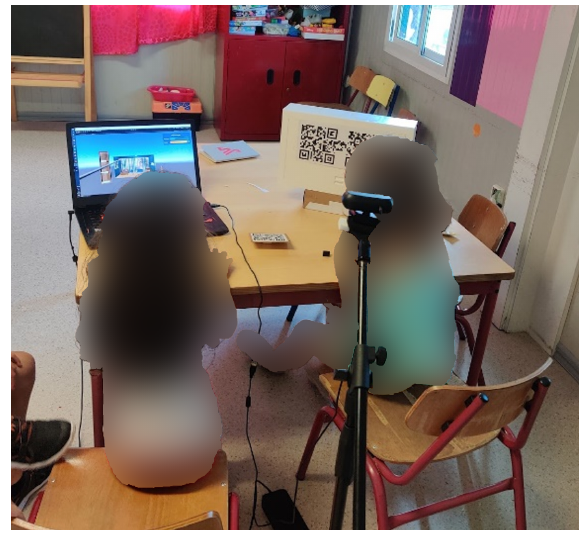
Figure 5. Two children playing during the formative